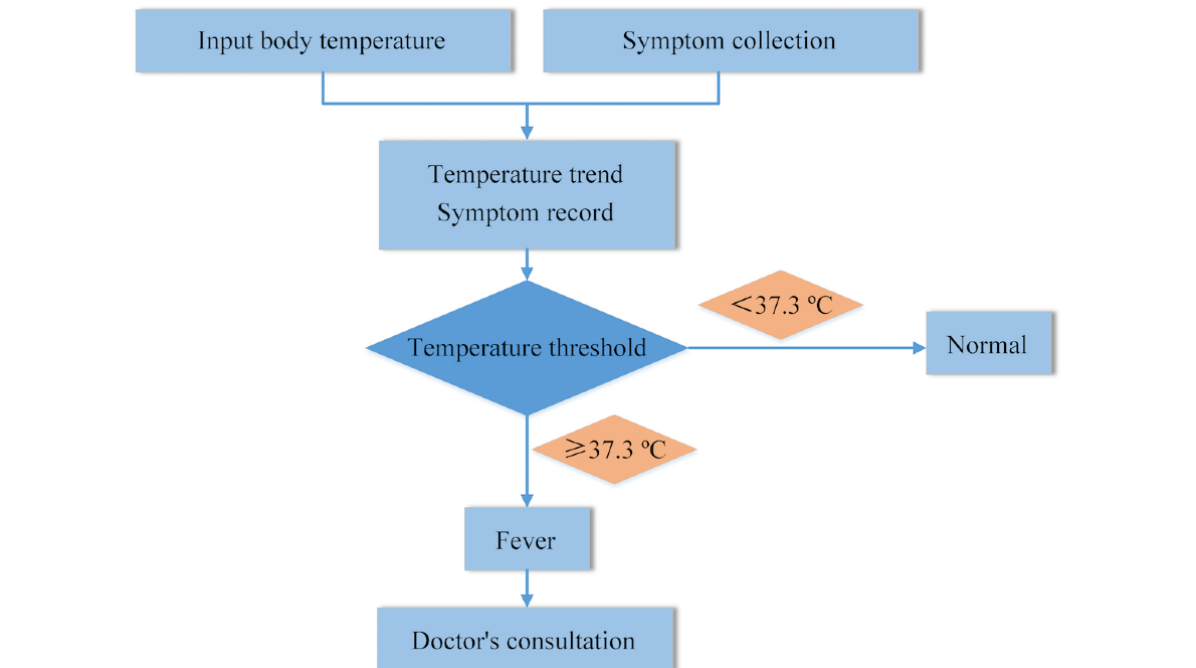
Figure 3. Flowchart for monitoring of COVID-19–related